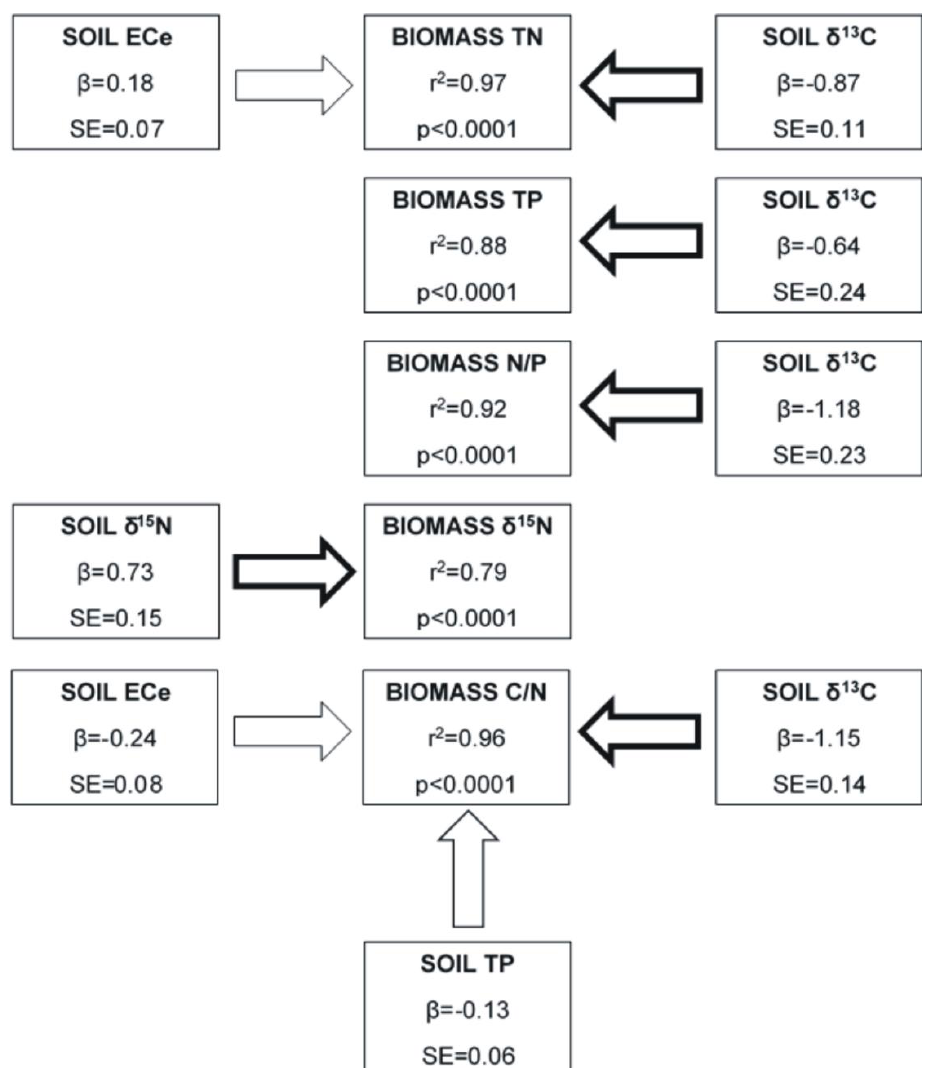
Figure 4. Results of multiple regression of chemical properties of biomass (dependent variables) and physical and chemical properties of soil (explanatory variables). Only statistically significant explanatory variables are shown. Coefficients of determination (r 2 ) and p values are given for regression of all non- collinear independent variables, namely soil moisture, electric conductivity, soil phosphorous content, soil δ 15 N and soil δ 13 C. Bold arrows indicate |β| >